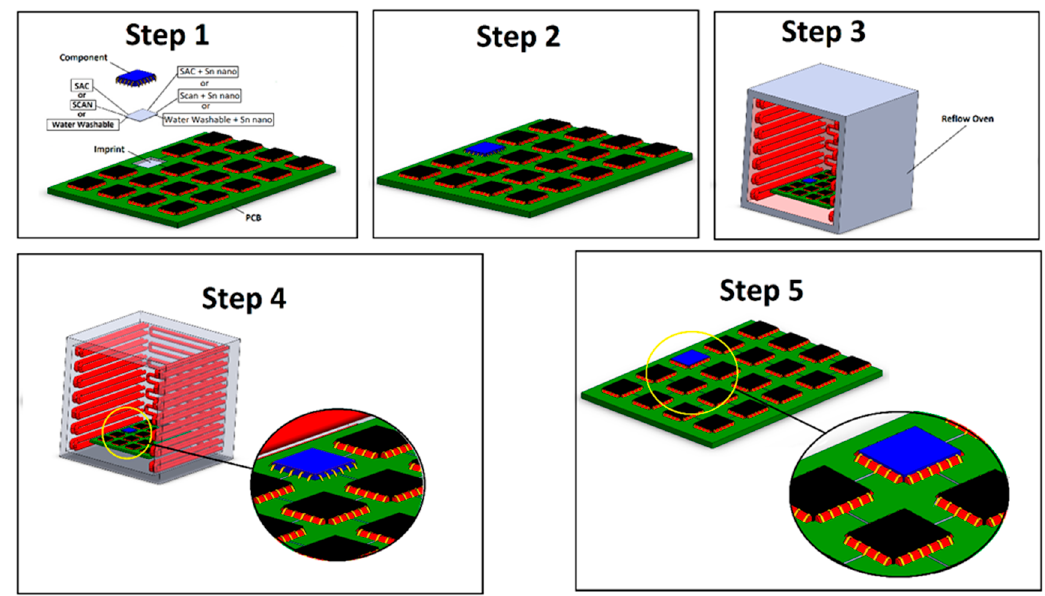
Figure 3. Illustration for soldering steps for components on printed circuit boards (PCBs) using different solder pastes.